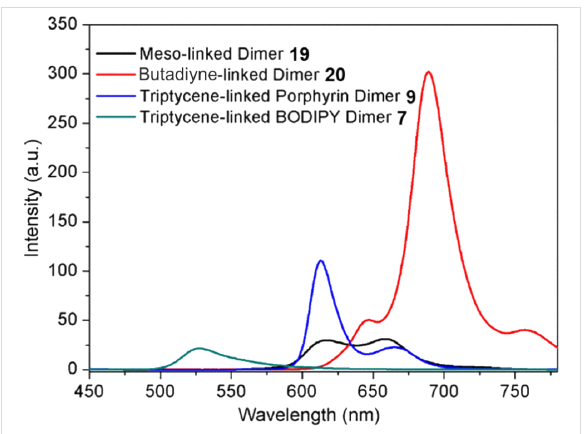
Figure 10: Fluorescence emission spectrum of various porphyrin/ BODIPY dimers with different linker groups in CHCl 3 . The excitation for compounds 9 , 7 , 19 and 20 was λ = 433 (23095), 370 (27027), 455 (21978) and 450 (22222) nm (cm − 1 ),